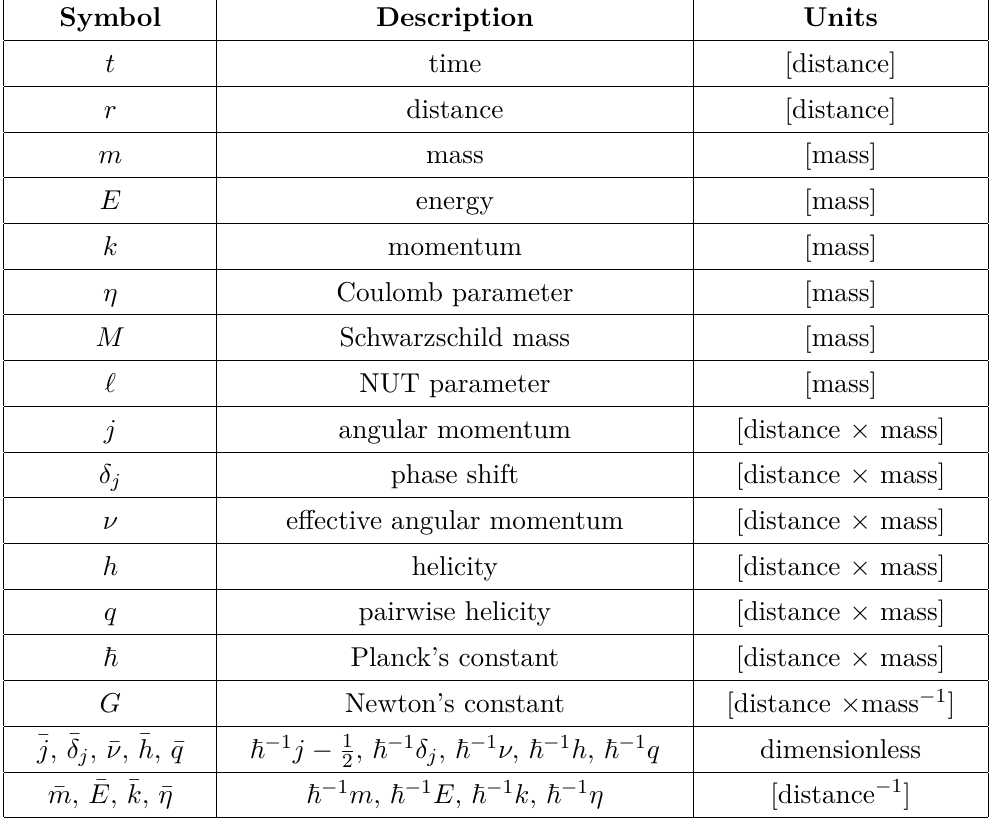
Table 1 . Different quantities used in their paper and their units when ~ 6 = 1 , c = 1